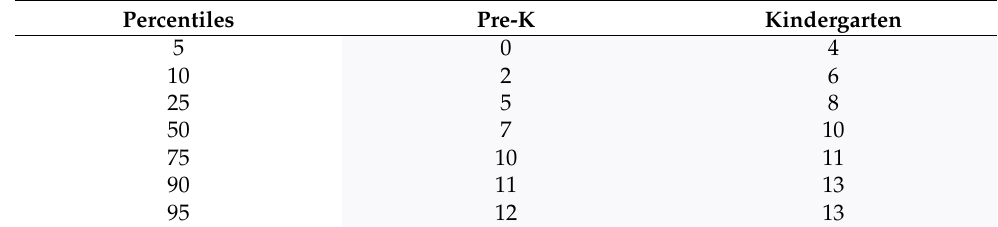
Table A3. Vocabulary.